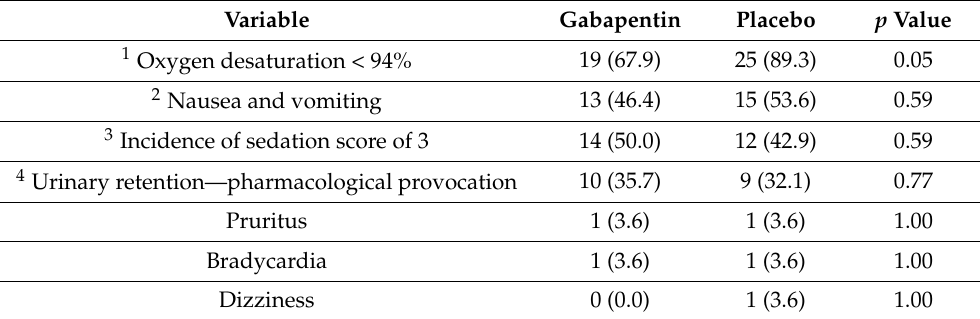
Table 4. Incidence of side effects in the gabapentin group ( n = 28) and the placebo group ( n = 28) in the observation period (PD 0–PD 3). Variable